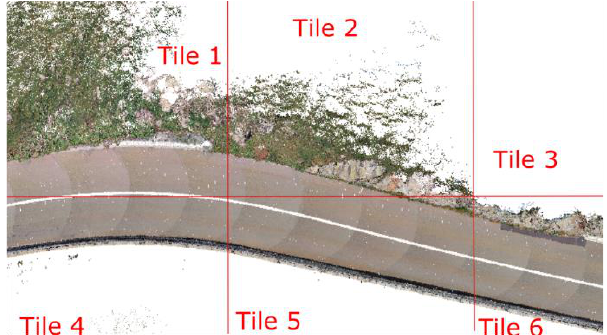
Figure 2. Point cloud